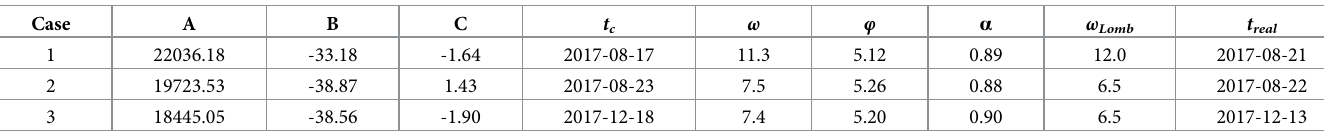
Table 2. Parameters of the LPPL model fits for three